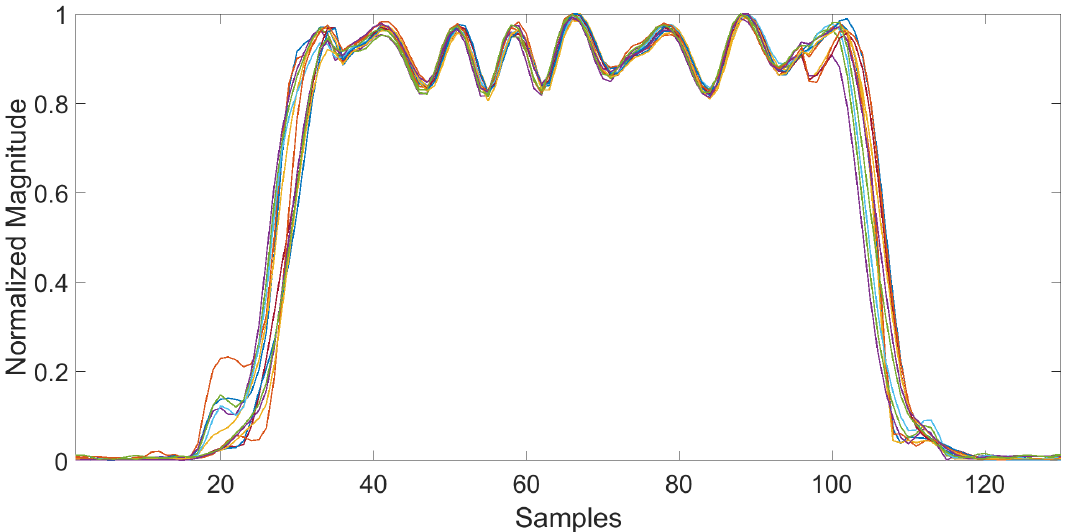
Figure 2. Normalized magnitude of 12 bursts (one for each wireless device).